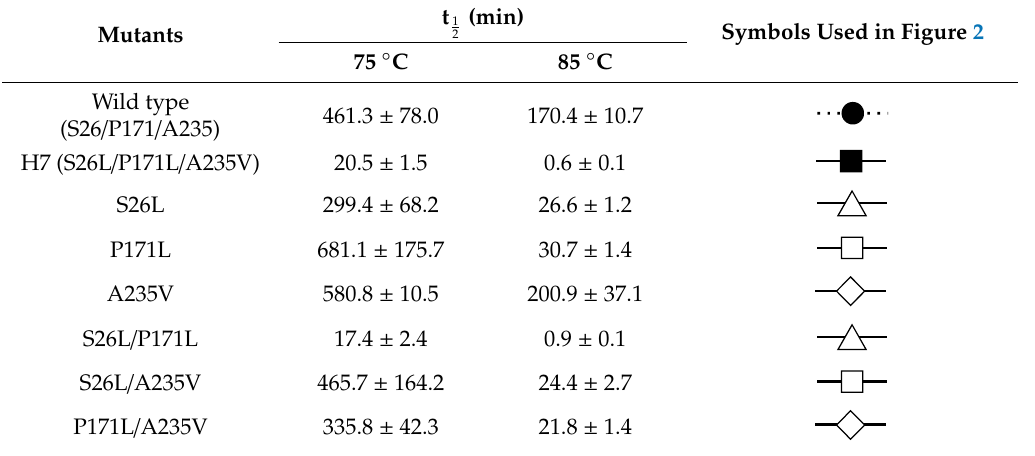
Table 2. Half-life of Ss β -gly wild type and mutants at 75 ◦ C and 85 ◦ C. (min) t 1 Mutants 2 75 ◦ C 85 ◦